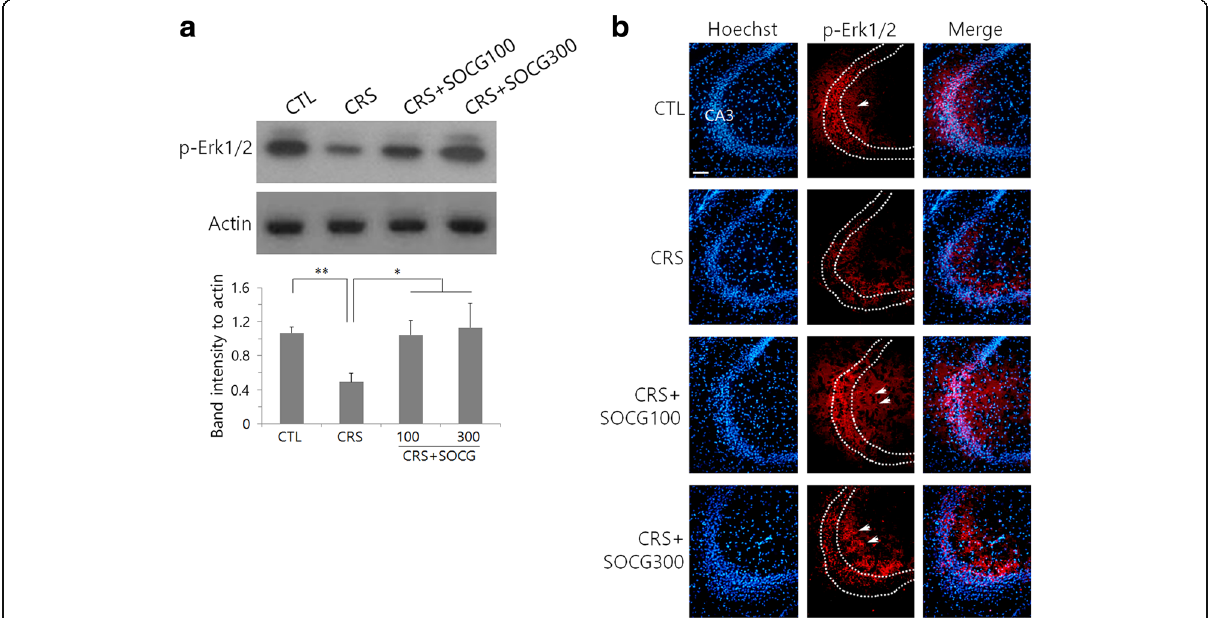
Fig. 3 Changes of phospho-Erk1/2 by SOCG treatment in the hippocampus of CRS animals. a Western blot analysis of phospho-Erk1/2 in the hippocampus. Images in the upper panel show the representatives from 4 independent experiments, and quantitation of protein band intensity relative to actin control are shown in the lower panel. **P < 0.01, **P < 0.01 (One-way ANOVA, n = 4). b Subfield distribution of phospho-Erk1/2 signals in the hippocampal CA3 area. Scale bar in (B): 200 μ